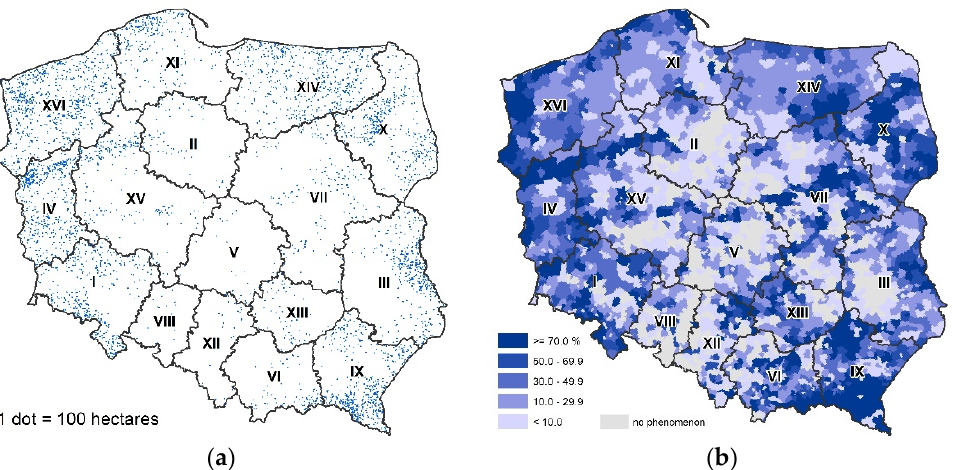
Figure 6. Area of land subsidised with support for habitat farming, in ha ( a ), and its share in the total area covered by pro-environmental RDP support ( b ). Source: own elaboration.